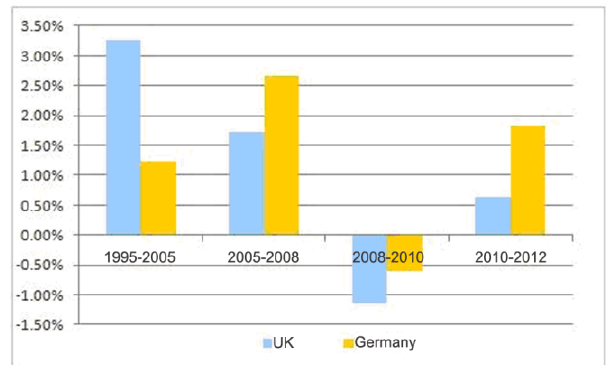
Figure 2. GDP (REAL), average yearly % change over the following period: 1995 – 2005, 2005 – 2008, 2008 – 2010, and 2010 – 2012 (data source: worldbank.org).